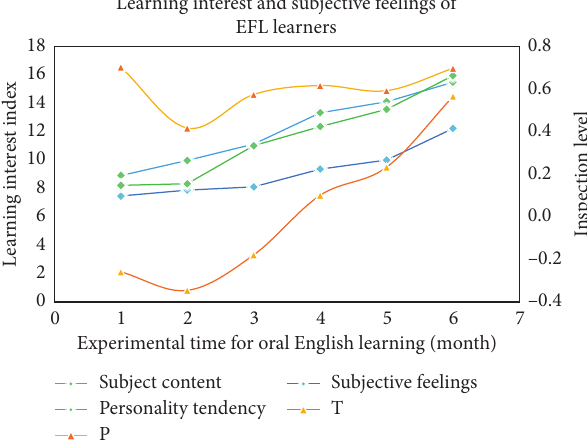
Figure 6: Learning interest and subjective feelings of EFL